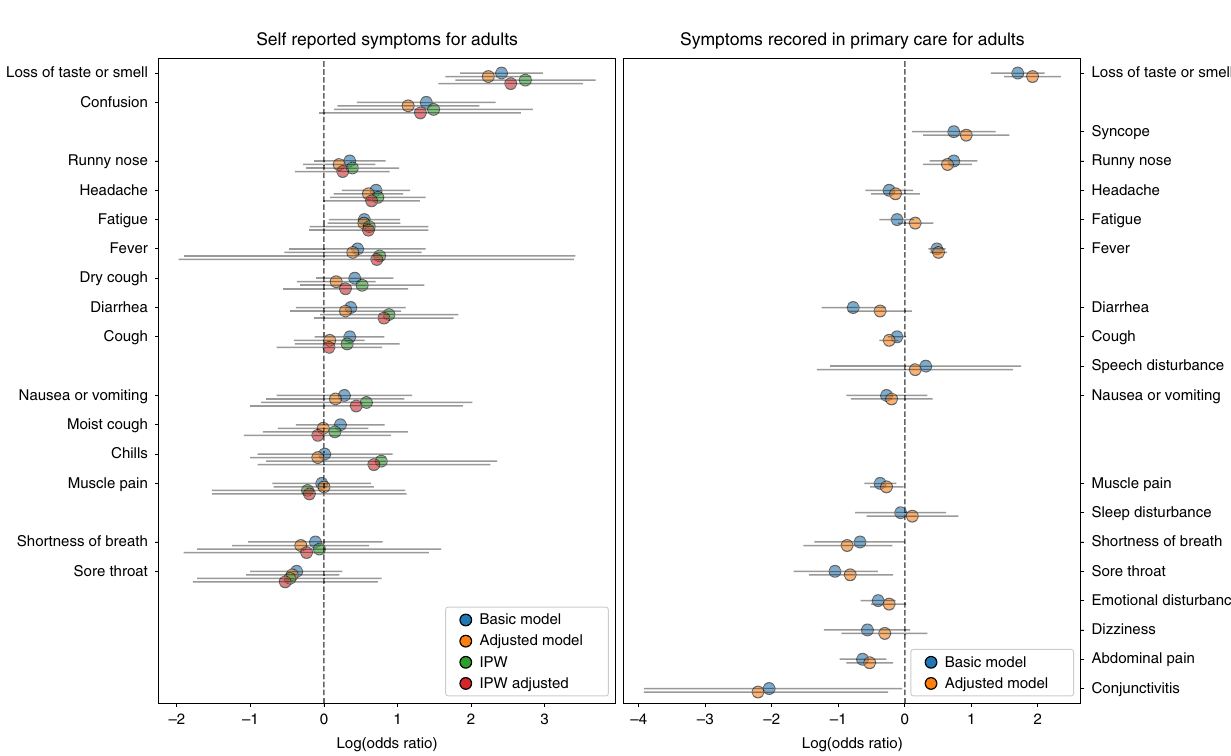
Fig. 3 Odds ratio analysis of symptoms prior to COVID-19 test. Log odds ratio (OR) calculated by the prevalence of symptoms 21 days prior to COVID-19 test for adults in self recorded symptoms ( n = 4843) versus EHR-captured symptoms ( n = 70,606). Calculated log odds ratios are presented along with gray lines indicating 95% con fi dence intervals. Blue circles represent log OR calculated from the basic model, orange circles represent log OR from the adjusted model, green circles represent log OR after applying Inverse probability weighting (IPW) to help address biases related to those receiving testing and red circles represents log OR from the adjusted model after applying